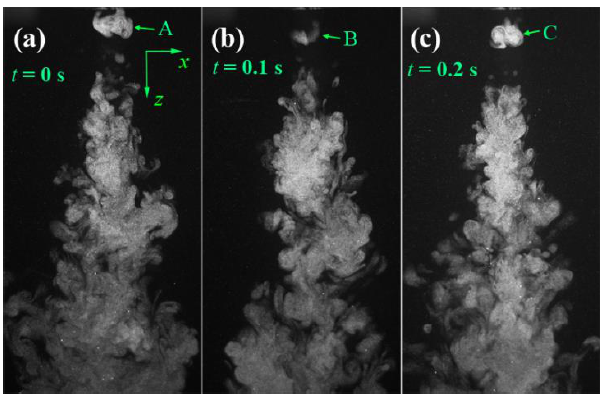
Figure 6. The visualized airflows in the “ x-z plane ( y = 30)” at different time instants of ( a ) t = 0 s, ( b ) t = 0.1 s, and ( c ) t = 0.2 s. The real size for each sub-image is 141.8 mm × 72.6 mm.